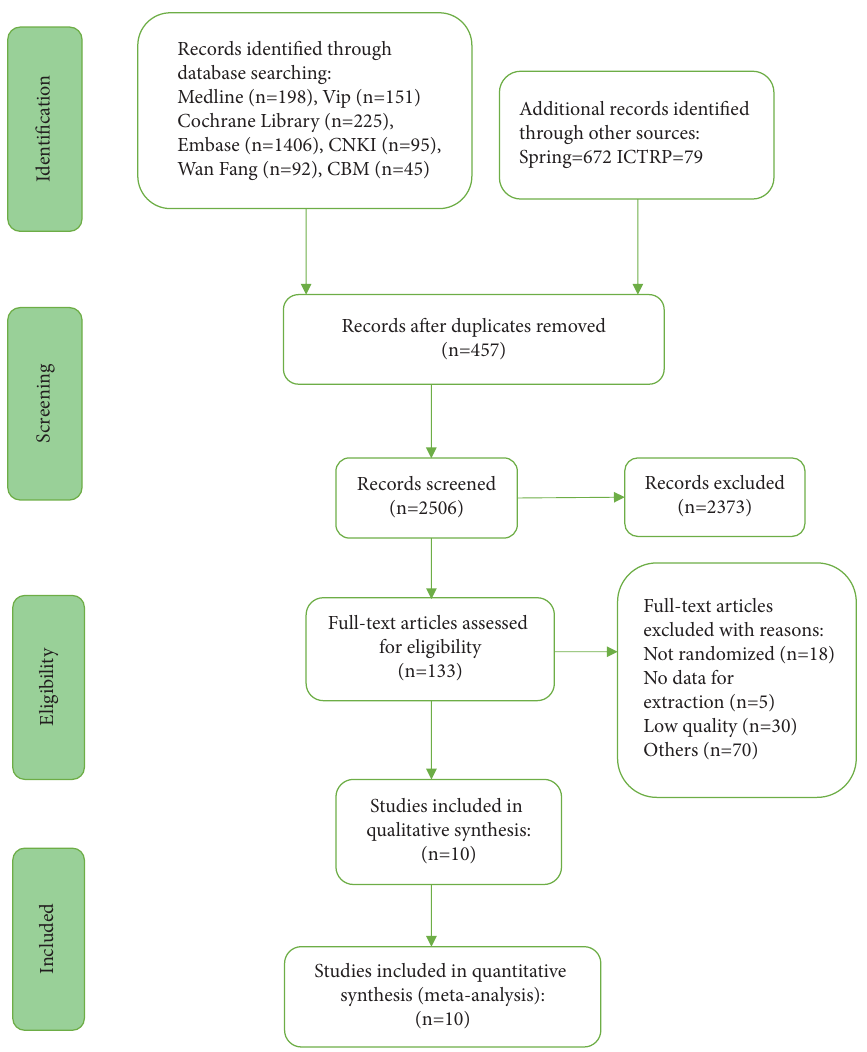
Figure 1: Flowchart of the selection